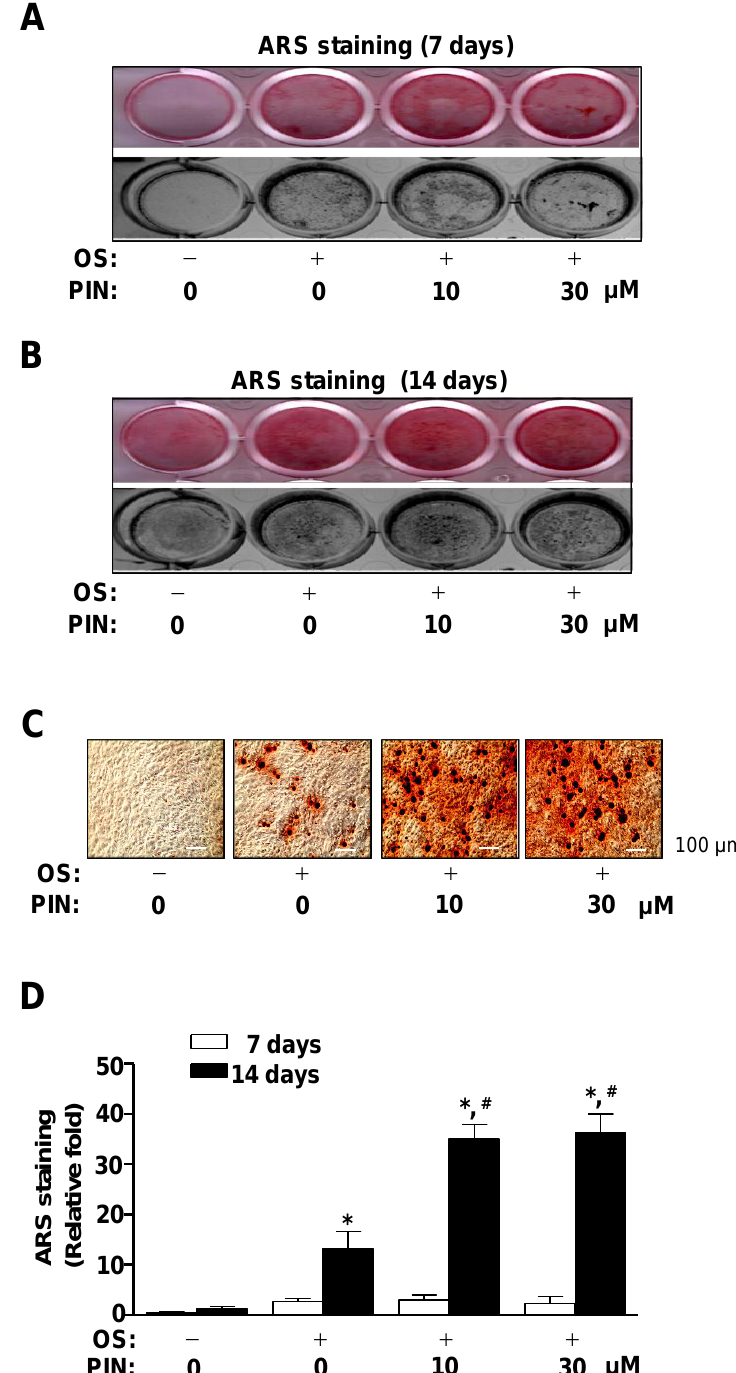
Figure 4. E ff ect of PIN on mineralized nodule formation during the late di ff erentiation of pre-osteoblasts ( A – D ). Pre-osteoblasts were cultured in OS with 10 and 30 µ M PIN, and mineralized nodule formation was performed using the Alizarin red S (ARS) staining assay at 7 ( A ) and 14 days ( B ). The ARS staining was detected by using a scanner (upper) and colorimetric detector (bottom) ( A , B ). Mineralized nodule formation was observed under a light microscope ( C ) and quantified by measuring at a wavelength of 590 nm using a spectrophotometer ( D ). Scale bar: 100 µ m. Data represent the mean ± S.E.M. of experiments. *, p < 0.05 indicates statistically significant di ff erence, compared with the control. #, p < 0.05 indicates statistically significant di ff erence when compared with